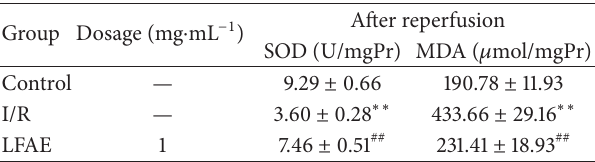
Table 2: Effects of LFAE on SOD activity and MDA level. Values are means with their standard deviation ( 𝑥 ± 𝑠 , 𝑛 = 8